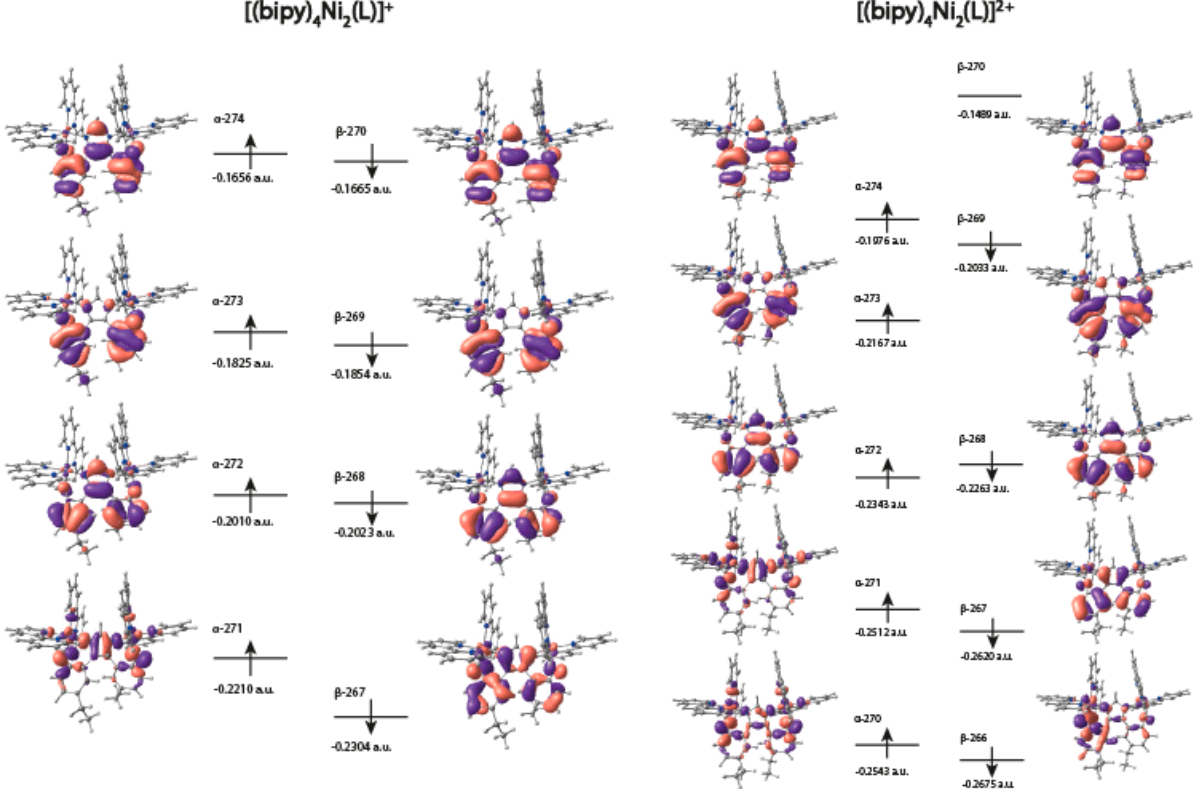
Figure 5. Calculated energy level diagram for α - and β -MOs in the cation [(bipy) 4 Ni 2 (L)] + and its oxidized form [(bipy) 4 Ni 2 (L)] 2+ .